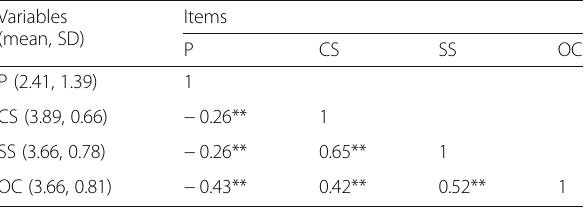
Table 3 Intercorrelations between presenteeism (P), coworker support (CS), supervisor support (SS), and organizational commitment (OC)